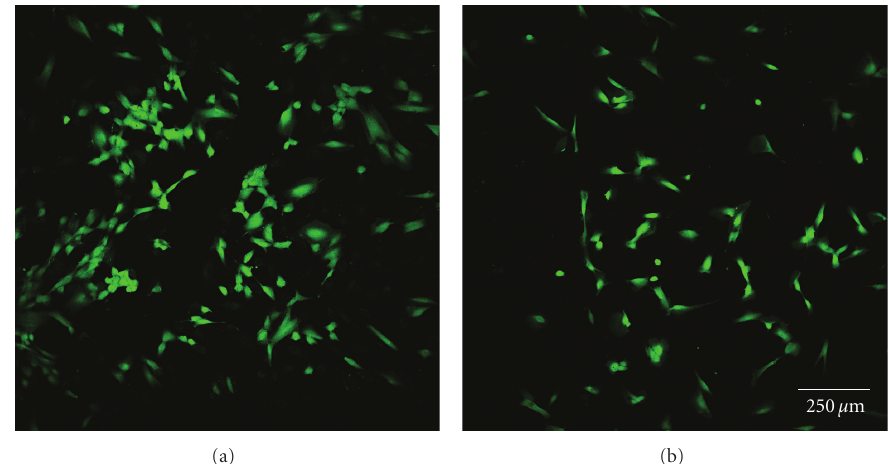
Figure 5: Fibroblast cells cultured on glass discs coated with hexylated polymer and spin coated with amorphous silicon dioxide after 24 h (a) and 72h